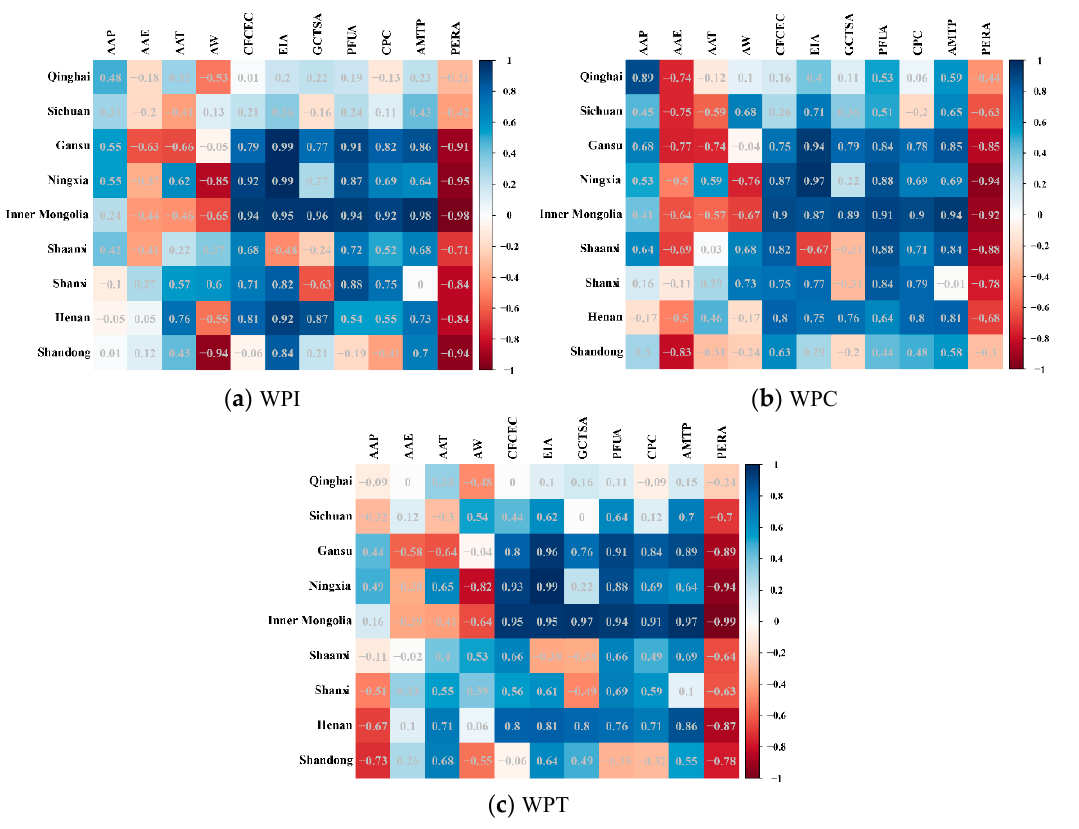
Figure 4. Correlation coefficients between water productivity and influencing factors. ( a ) Correlation coefficient between the WPI of the provinces (autonomous regions) and the influencing factors. ( b ) Correlation coefficient between the WPC of the provinces (autonomous regions) and the influencing factors. ( c ) Correlation coefficient between the WPT of the provinces (autonomous regions) and the influencing factors. The depth of the color indicates the size of the correlation coefficient. The lighter the color, the smaller the correlation coefficient, and the darker the color, the larger the correlation